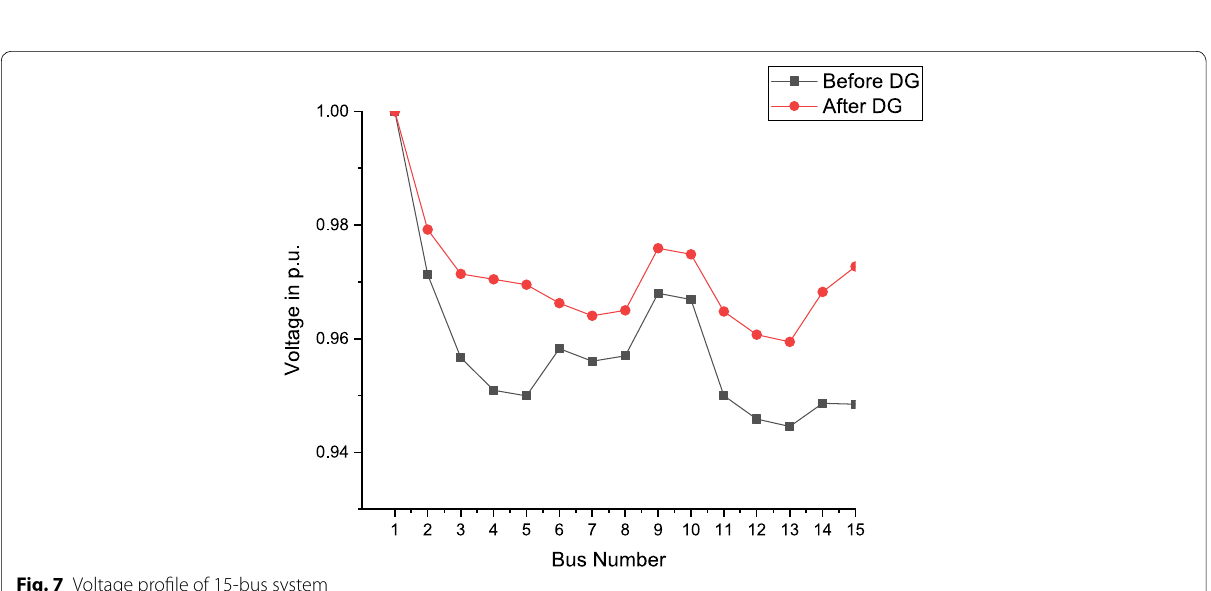
Fig. 7 Voltage profile of 15-bus